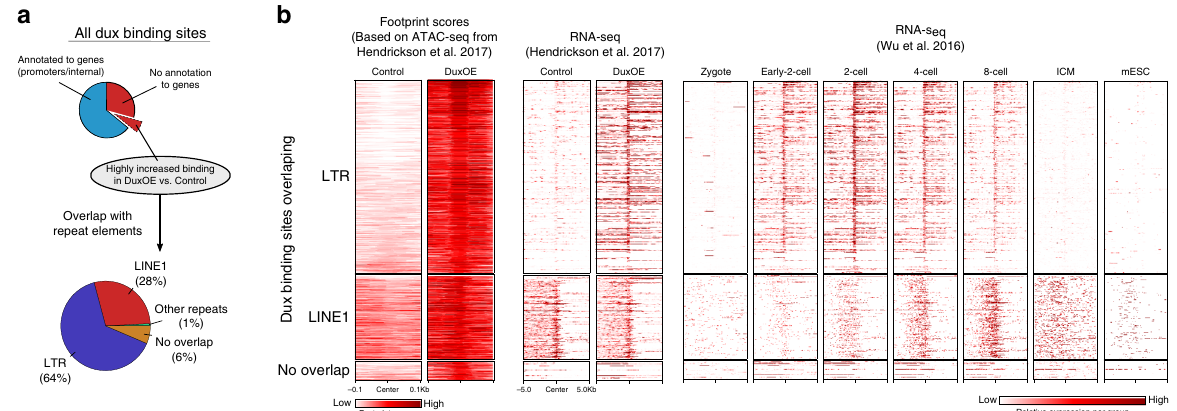
Fig. 5 Dux binding in fl uences expression of repeat elements. a Dux binding sites overlap with repeat elements. All potential Dux binding sites are split into sites either overlapping promoters/genes or without annotation to any known genes (upper circle, blue/red). The bottom pie chart shows a subset of the latter, additionally having highly increased binding (log2(FC) > 1), annotated to repeat elements including LTR/LINE1 elements. b Dux induces expression of transcripts speci fi c for preimplantation. Genomic signals for the Dux binding sites which are bound in Dux OE with log2(FC) footprint score >1 (i.e., upregulated in Dux OE) are split into overlapping either LTR, LINE1 or no known genetic elements (top to bottom); each row indicates one binding-site/ associated gene loci. Footprint scores (±100 bp from Dux binding sites, left column) indicate the differential Dux binding between control and Dux OE (in vitro). RNA-seq shows the normalized read-counts from matched RNA-seq samples (center columns, in vitro) and throughout development (right columns, in vivo) within ±5 kb of the respective Dux binding sites. Dark red color indicates high